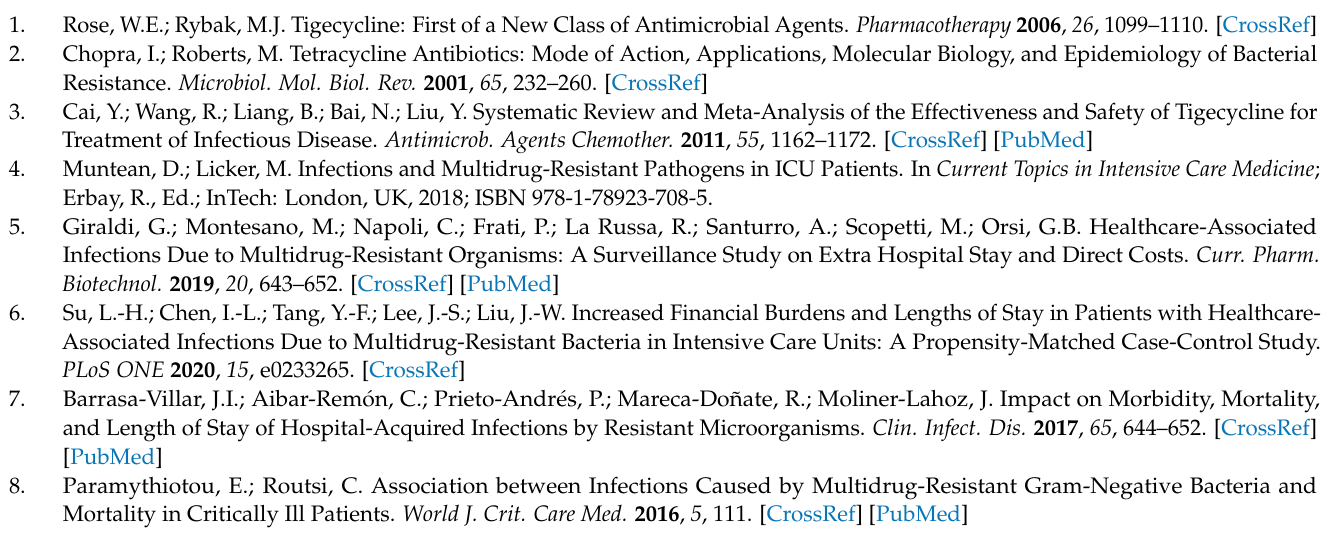
Table S2: Class of antibiotics used in the treatment of patients within ten days before Tigecycline